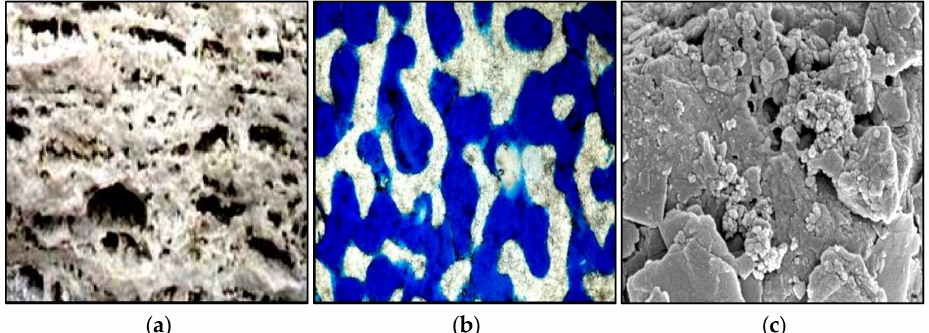
Figure 4. Multi-scale pore structure image after enhancement processing. ( a ) Macroscale image; ( b ) Mesoscale image; ( c ) Microscale image.